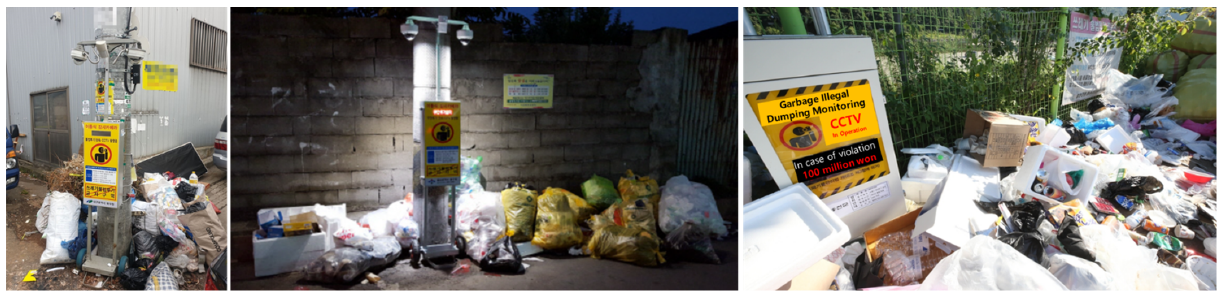
Figure 1. Limitations of the current illegal dumping monitoring system.